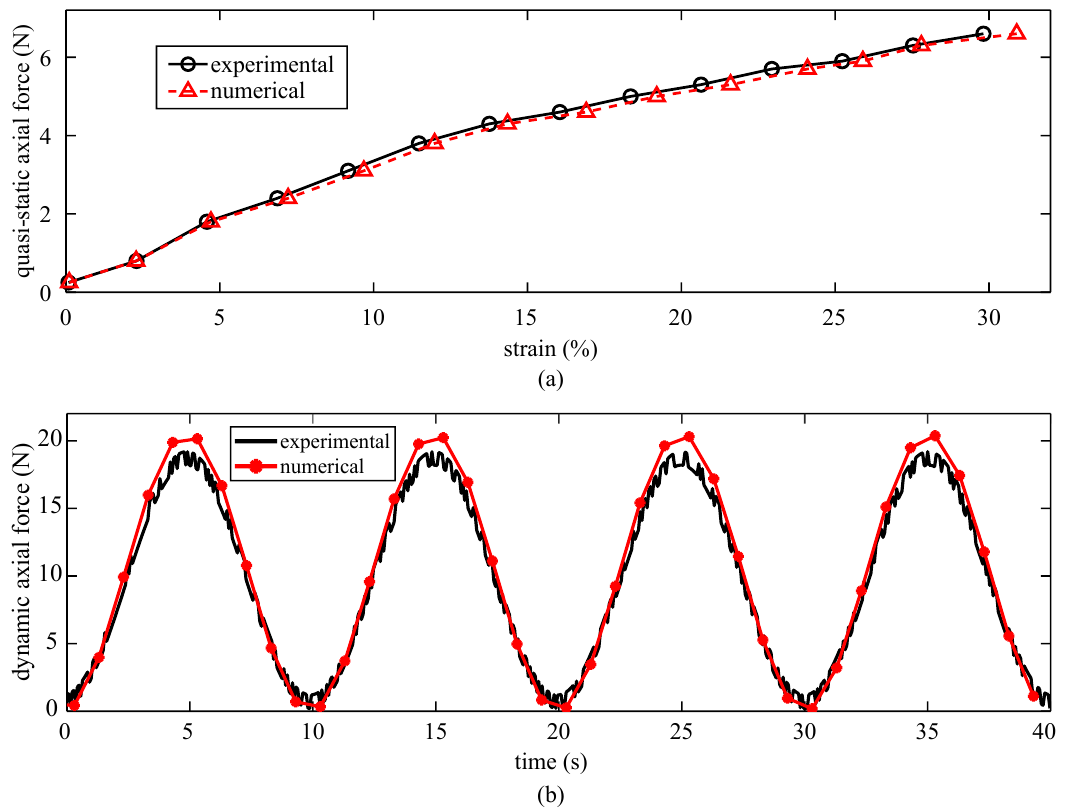
Figure 5. Validation of the numerical models: ( a ) experimental versus numerical quasi-static axial force–strain curves for a free-standing SEC sensor, and ( b ) experimental versus numerical dynamic axial force–strain curves for the partially adhered SEC-canine skin